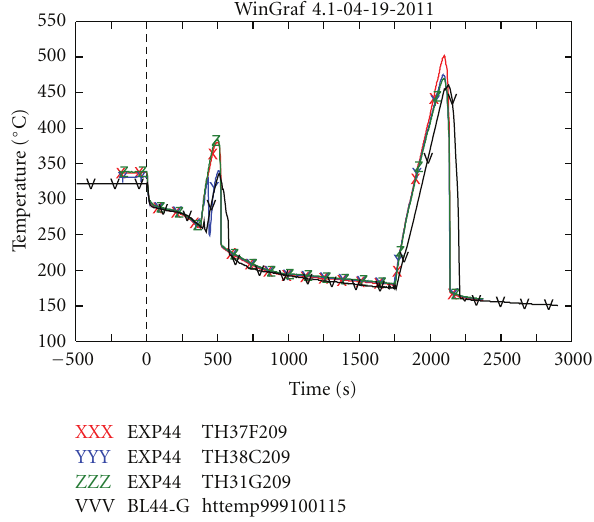
Figure 18: Cladding temperature at high